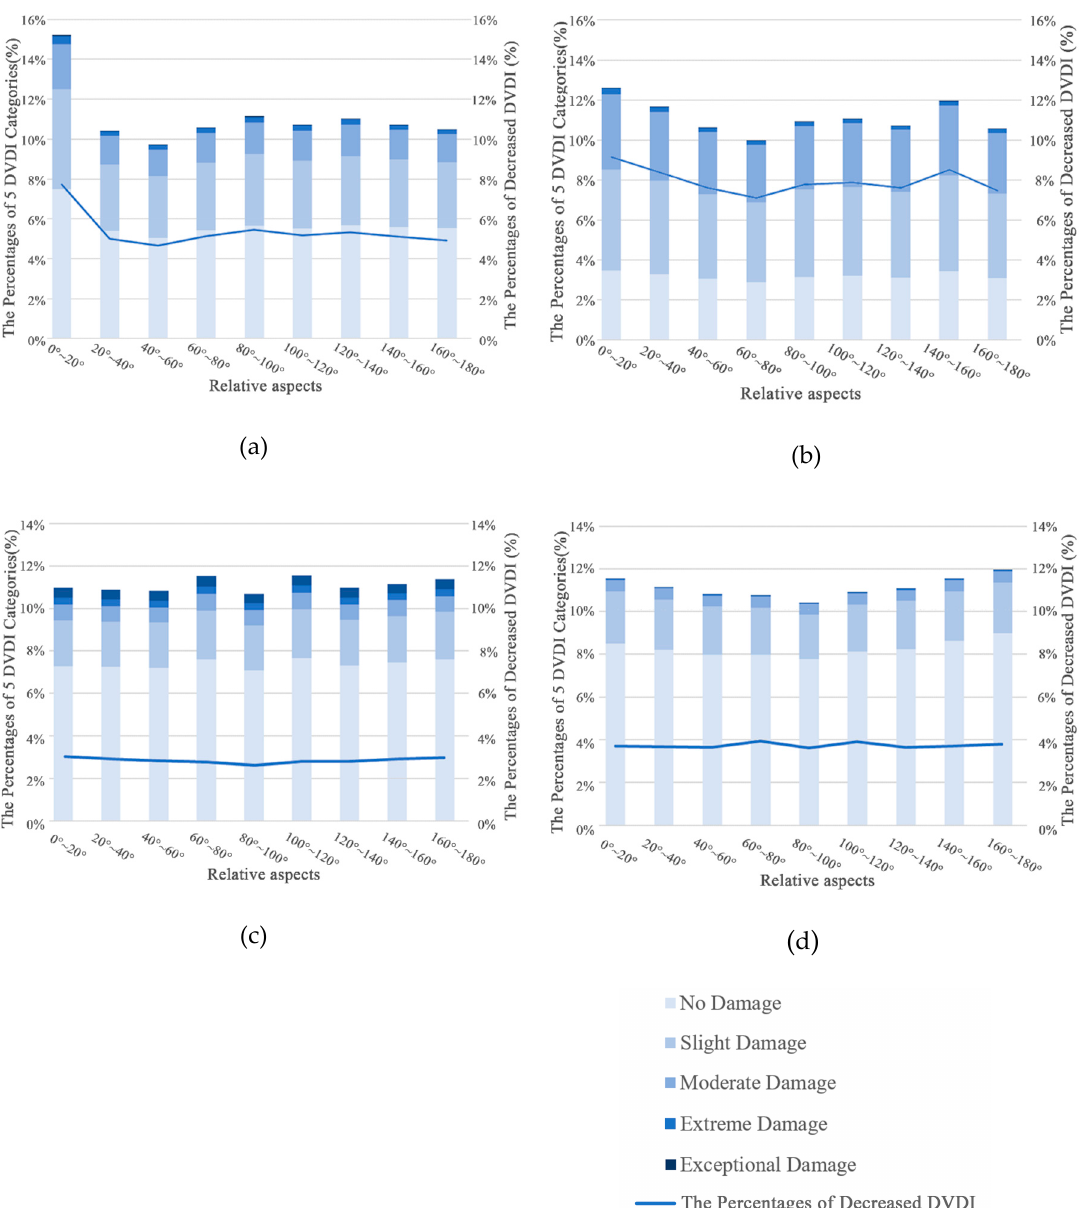
Figure 8. The percentages of damaged areas for different relative aspects. ( a ) Typhoon Mujigae (201522), ( b ) Typhoon Mangkhut (201822), ( c ) Typhoon Usagi (201319), ( d ) Typhoon Vongfong (200214).